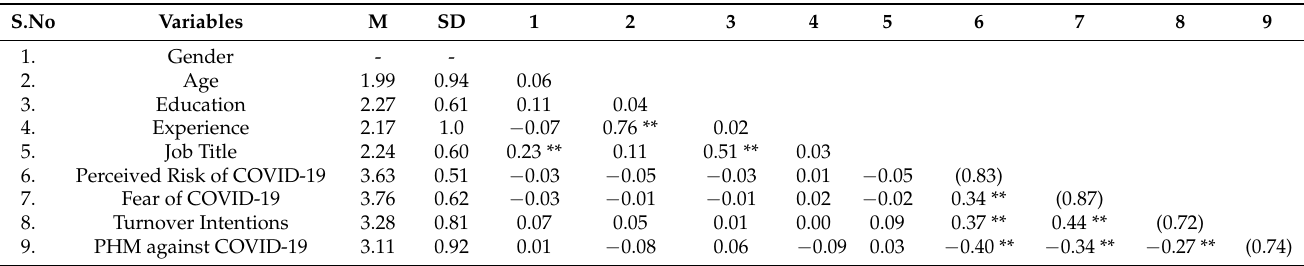
Table 4. Mean, standard deviation, reliability, and